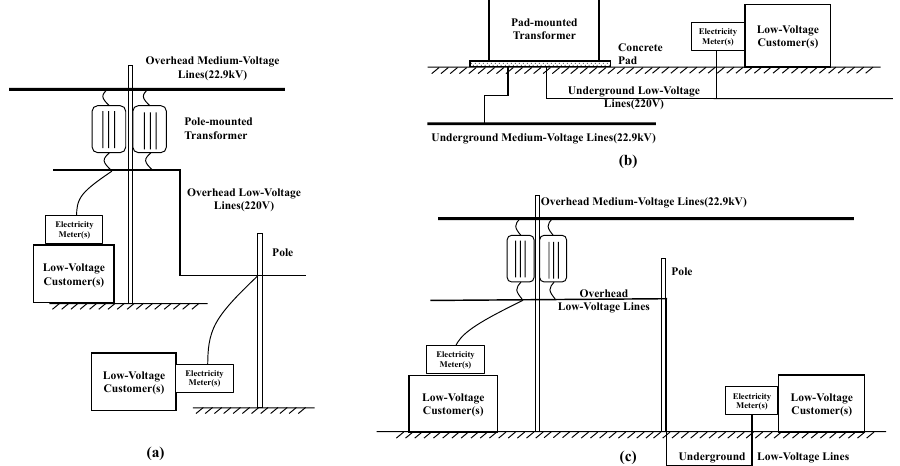
Figure 1. Low-voltage distribution configurations at KEPCO, Republic of Korea. ( a ) Low-voltage power system using overhead power lines. ( b ) Low-voltage power system using underground power lines. ( c ) Mixed type of the overhead and underground power lines.